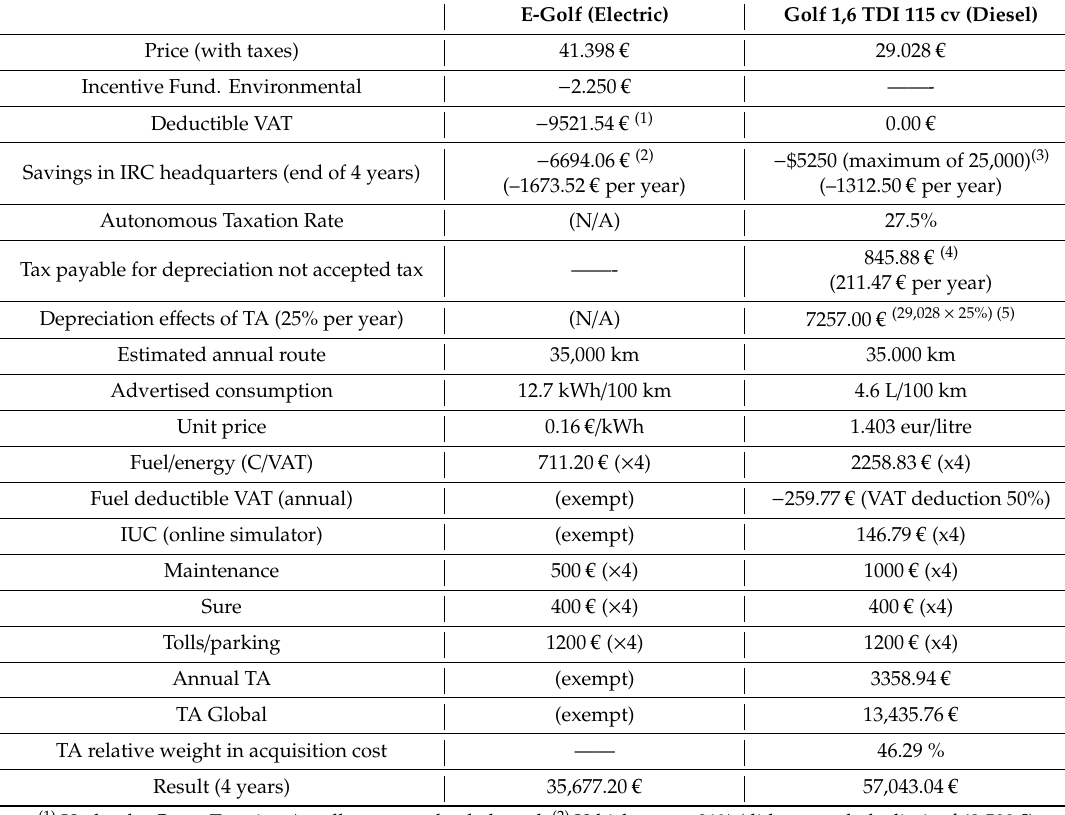
Table A1. 4-year exercise statement—Definitive acquisition (Comparison of passenger light vehicles).